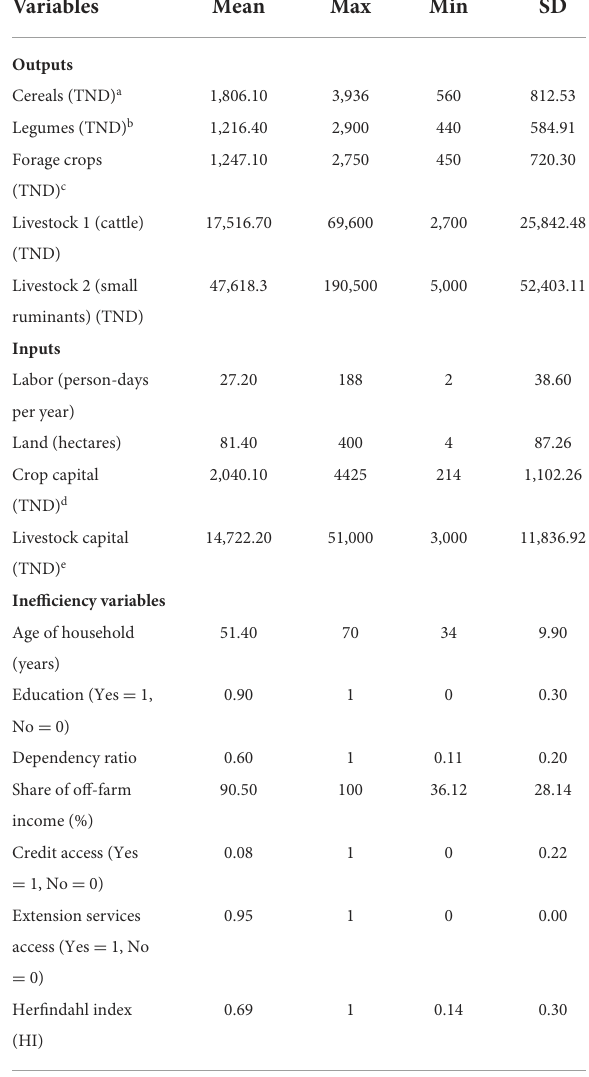
TABLE 1 Characteristics of sample households–socio-demographic variables used in the empirical model.